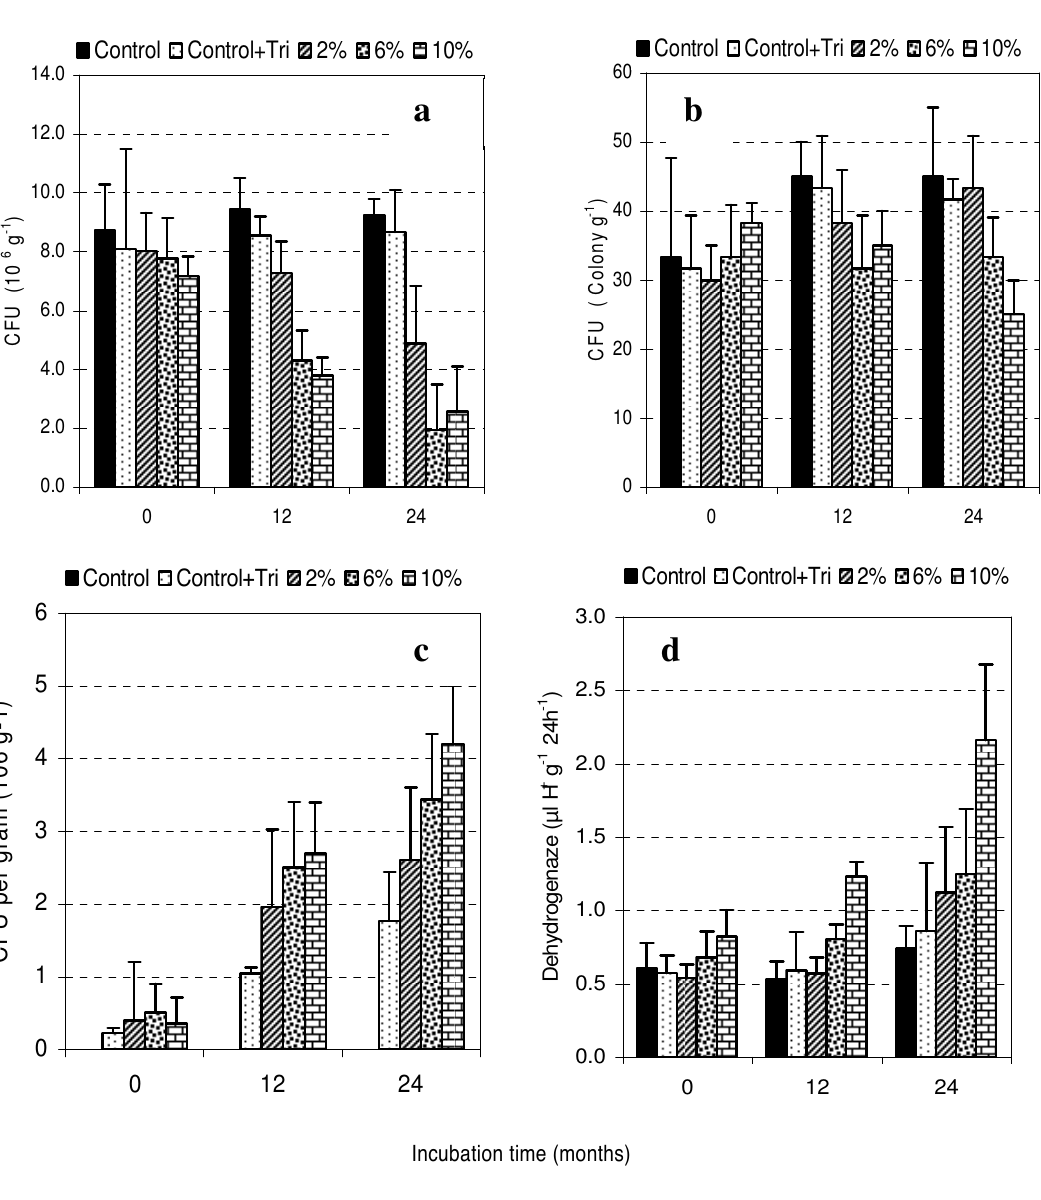
Fig. 3. Effect of incubation of organic amendment in soil on: a, total fungal population (CFU, 106 g-1); b, Rhizoctonia solani population (CFU, colony g-1); c, dehydrogenase enzyme activity (hydrogen ions, μ l g-1 24 h-1). Vertical bars represent the standard deviation of replicates from the